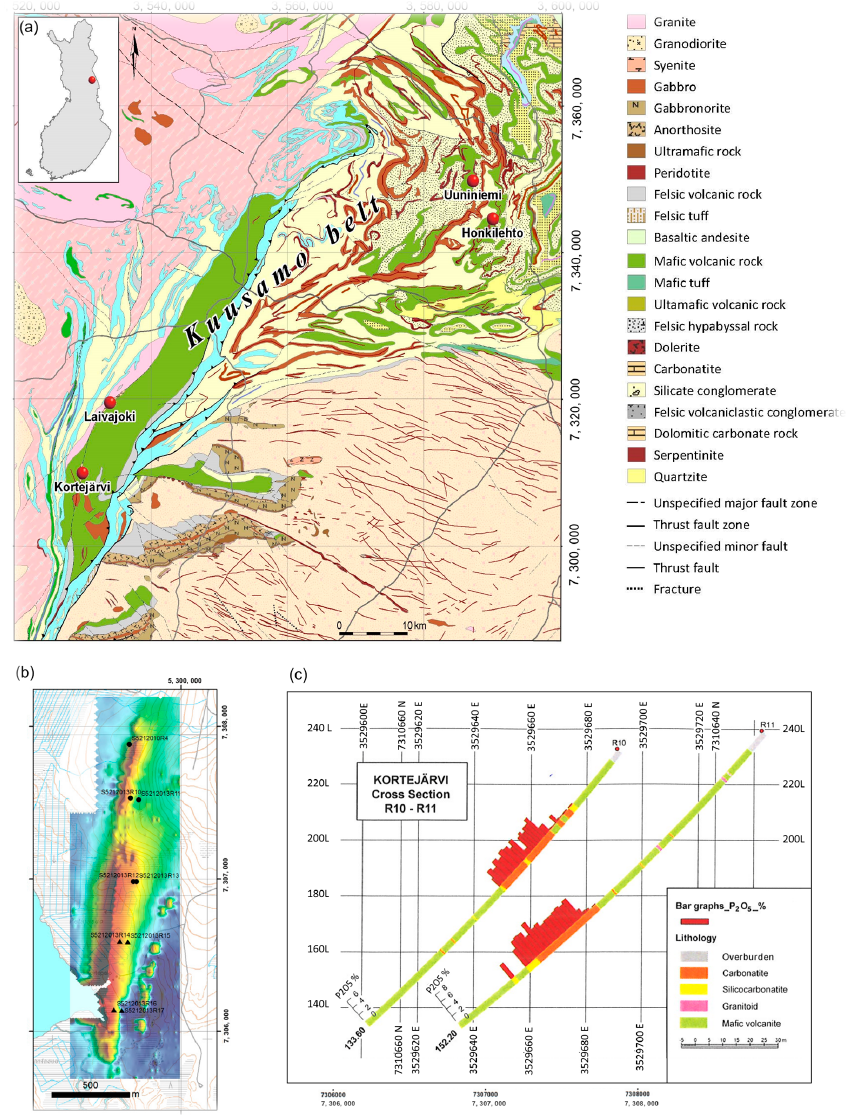
Figure 6. ( a ) Locations of the Kortejärvi-Laivajoki carbonatite intrusions and metasomatic-hydrothermal REE enrichments at Uuniniemi and Honkilehto in the Kuusamo belt; ( b ) a magnetic ground survey map showing the location of the drill holes; ( c ) Cross section in Kortejärvi carbonatite showing P 2 O 5 contents in drill cores R10 and R11 (modified from [13]). Coordinates correspond to Finnish National Coordinate System ETRS-TM35FIN.